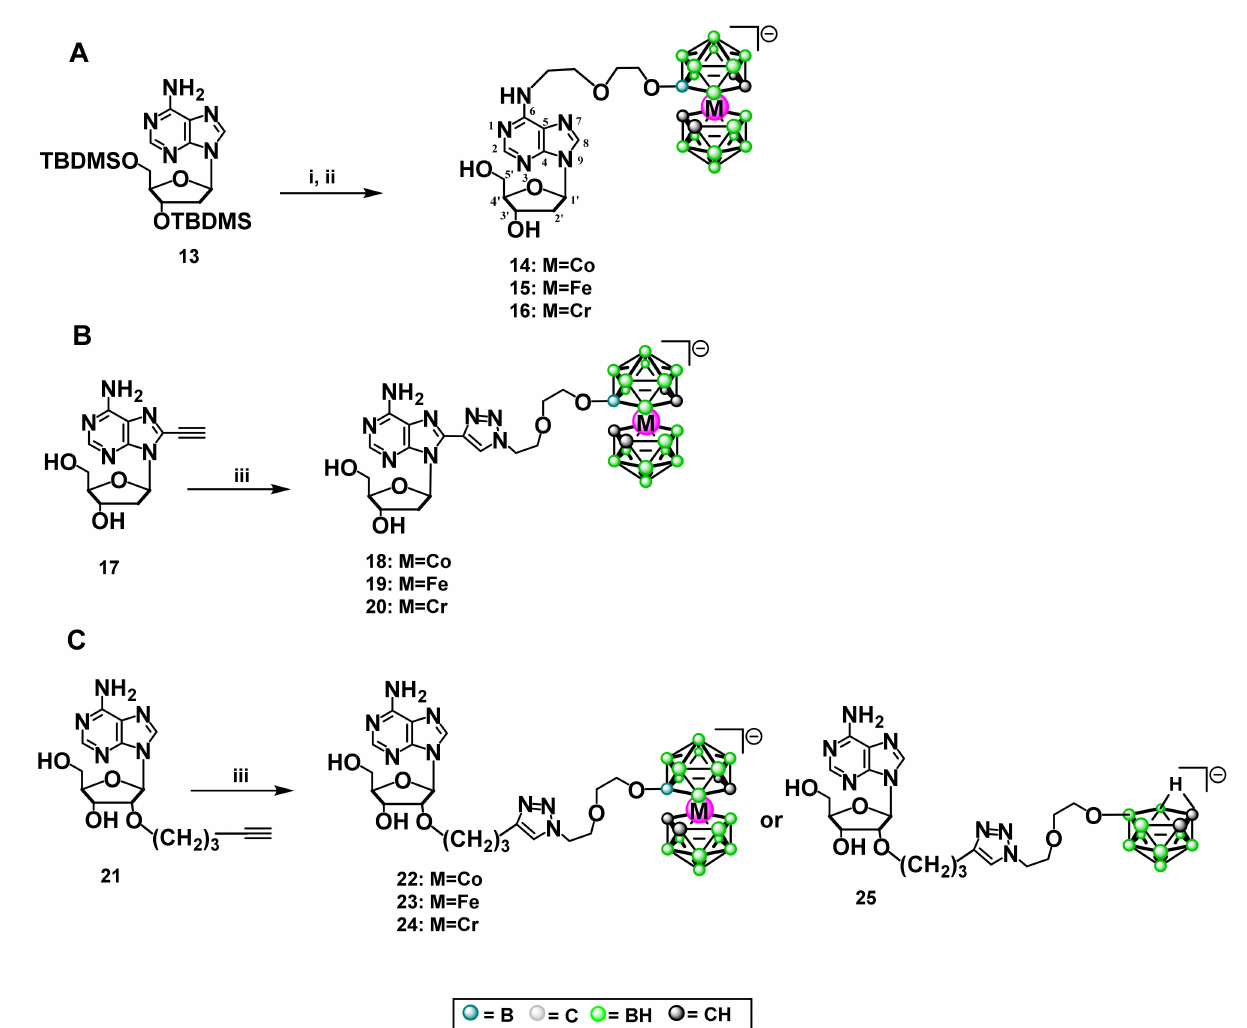
Scheme 3. ( A ) General procedure for the synthesis of 2 (cid:48) -deoxyadenosine modified with metallacarborane complexes bearing Co, Fe, Cr ( 14 , 15 , 16 ) at position N 6 : (i) NaH/toluene, 5 , 6 , or 7 , 70 ◦ C, (ii) TBAF/THF; ( B ) general procedure for the synthesis of 2 (cid:48) -deoxyadenosine modified with metallacarboranes bearing Co, Fe, Cr ( 18 , 19 , 20 ) at position 8: (iii) 9 , 10 or 11 , CuSO 4 × 5H 2 O, sodium ascorbate, tert -BuOH/H 2 O (1:1); ( C ) general procedure for the synthesis of adenosine modified with metallacarboranes bearing Co, Fe, Cr ( 22 , 23 , 24 ) or nido -7,8-dicarbaundecaborate ( 25 ) at carbon 2 (cid:48) : (iii) 9 , 10 , 11 or 12 , CuSO 4 · 5H 2 O, sodium ascorbate, tert -BuOH/H 2 O